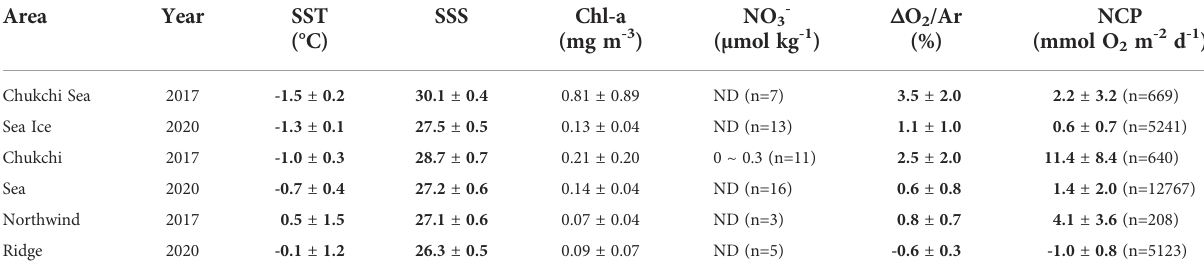
TABLE 1 Average and standard deviation of measured parameters for each region in 2017 and 2020.